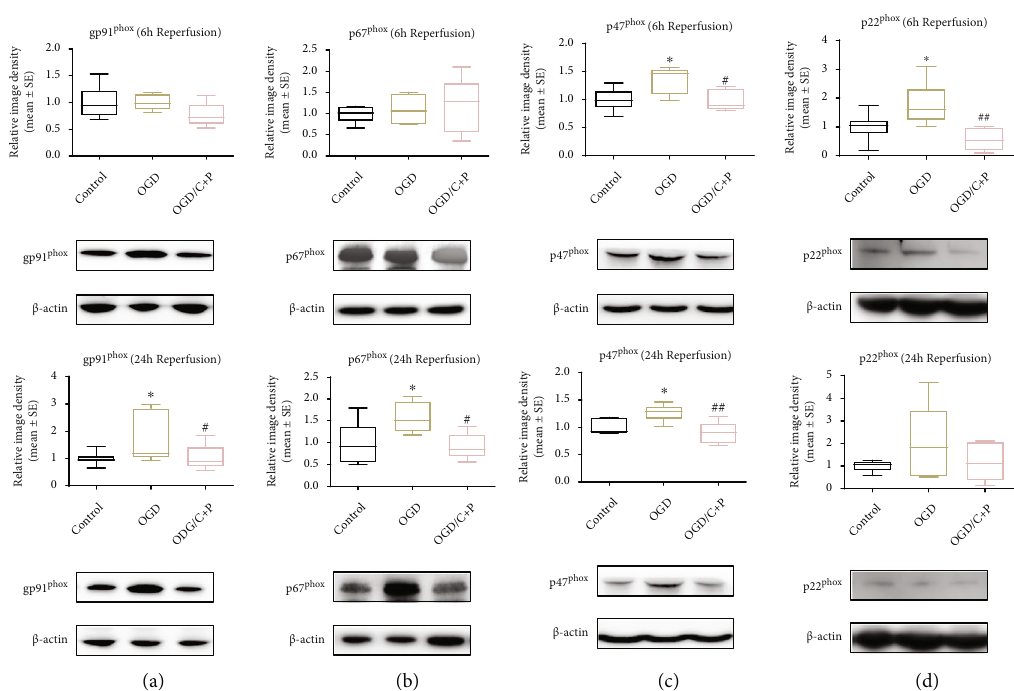
Figure 4: C+P reduced protein levels of NOX subunits after OGD/R in SHSY5Y cells. (a) gp91 phox , (b) p67 phox , (c) p47 phox , and (d) p22 phox , identi fi ed by Western blot at 6 and 24 hours of reoxygenation. Levels of gp91 phox and p67 phox protein increased after OGD but decreased after C+P therapy at 24 hours of reoxygenation. Moreover, p47 phox levels increased after OGD, but C+P lowered this expression at 6 and 24 hours of reoxygenation. OGD induced the elevation of p22 phox , and there was a greater reduction in p22 phox expression in the OGD/C+P treatment group versus the OGD group at 6 hours of reoxygenation. ∗ p < 0 : 05 versus the OGD group; # p < 0 : 05 , ## p < 0 : 01 versus the OGD/C+P group. Results are shown as mean ± SE of three independent experiments. The representative immunoblots are